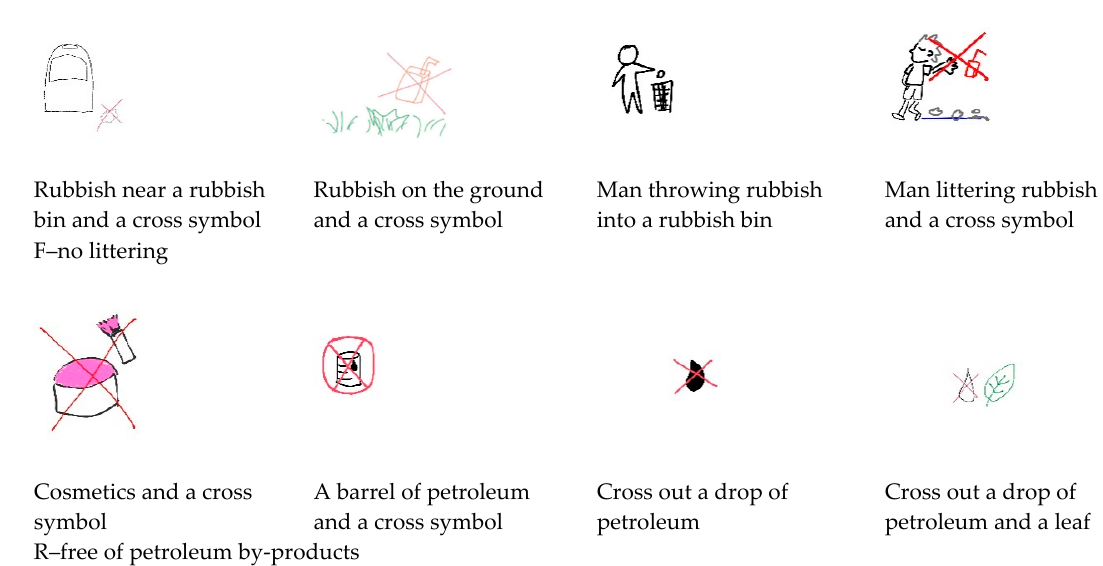
Figure 2. Examples of representation for the least and most familiar, concrete, and easily visualized environmentally friendly message.